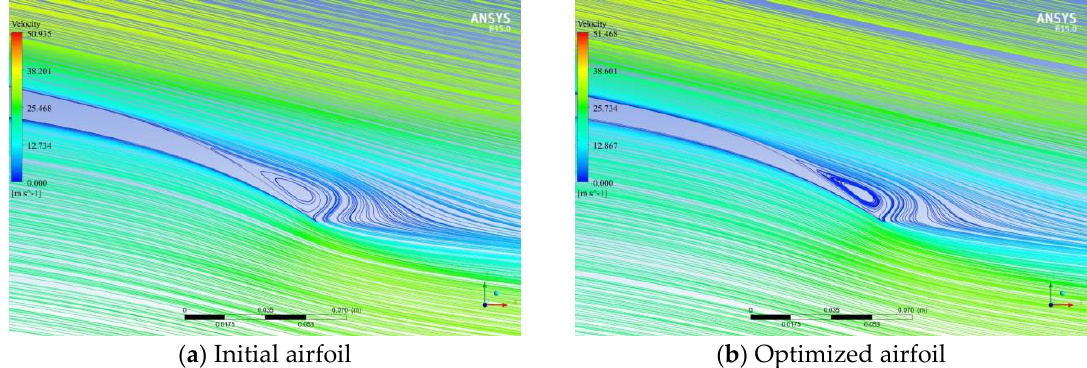
Figure 25. Velocity streamlines of the initial and optimized airfoils near the trailing edge at α = 4°.